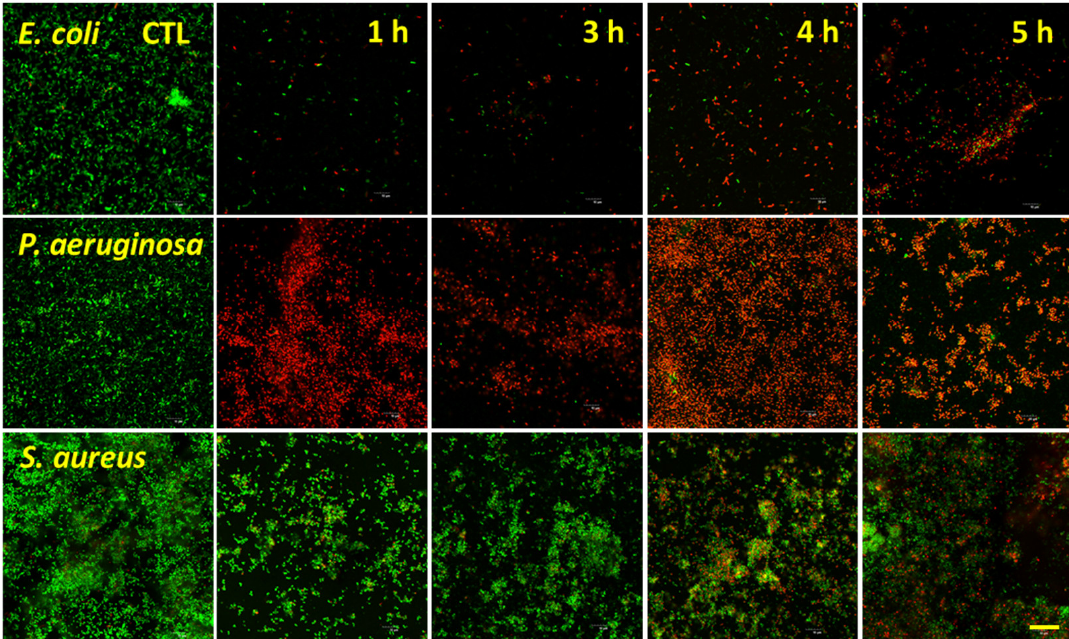
Figure 5. Confocal microscopy micrographs of E. coli , P. aeruginosa , and S. aureus incubated on the surfaces of the titanium etched using 1 M NaOH for 1, 3, 4, and 5 h. Bacteria were inoculated on the etched samples at a concentration of 10 6 CFUs and incubated for 20 h. Cells were stained with a LIVE/DEAD BacLight™ bacterial viability kit. Scale bar represents 20 µm.